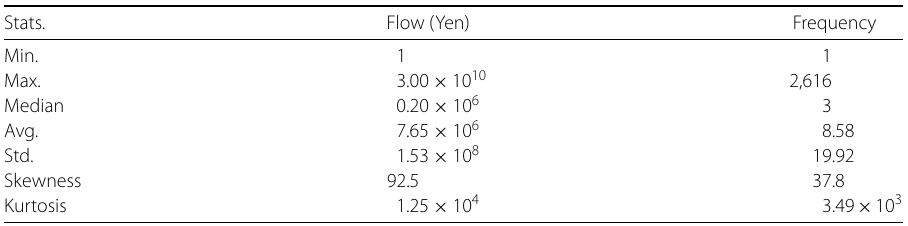
Table 2 Summary statistics for links’ flows and frequencies Stats. Flow (Yen) Frequency Min. 1 1 Max.